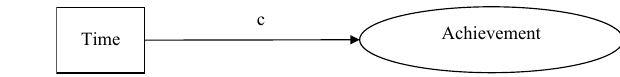
Fig. 1 The effect of time of achievement. The null‑model